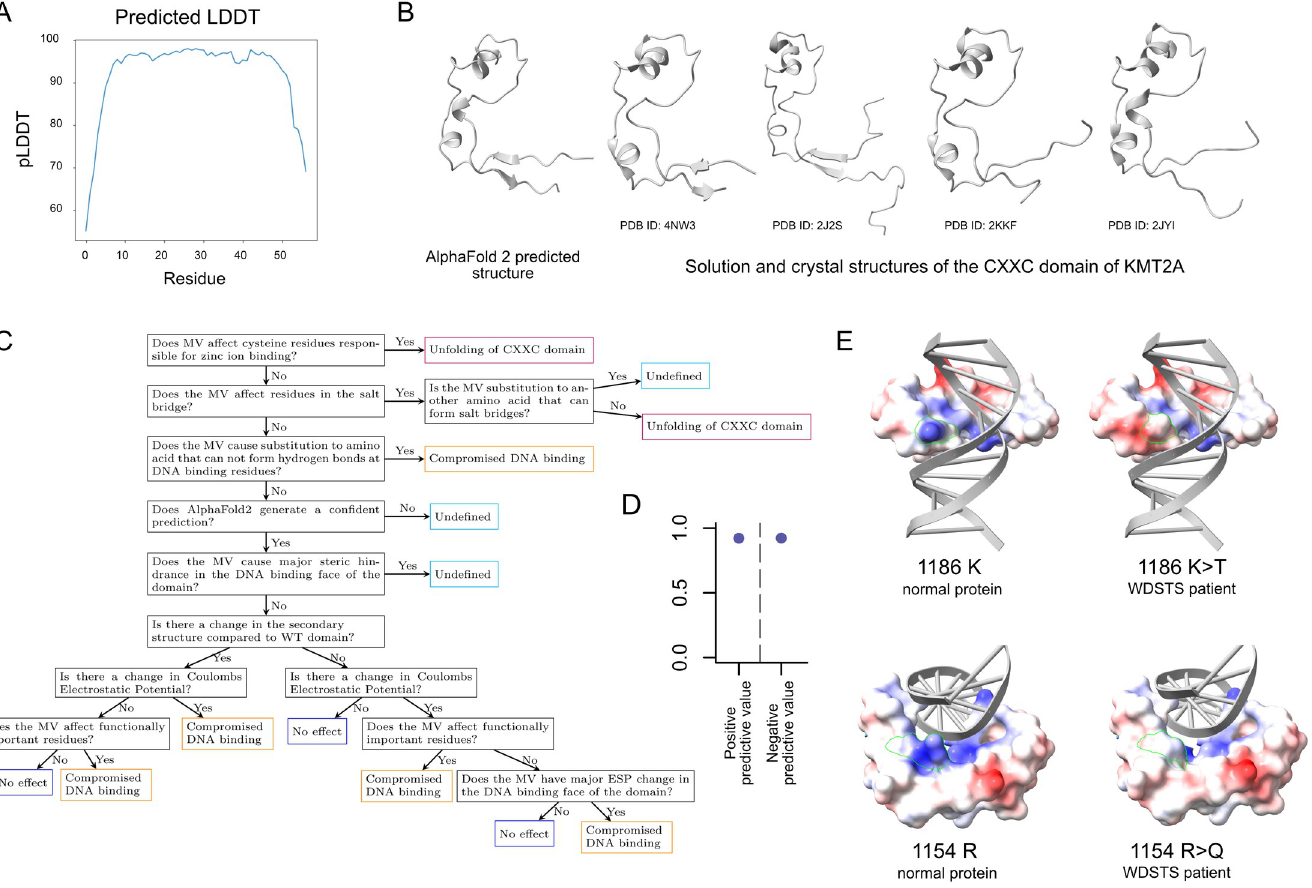
Fig 3. An AlphaFold2-based variant effect classification scheme for the CXXC domain of KMT2A. (A) Predicted LDDT values for the CXXC domain of KMT2A. (B) The AlphaFold2-predicted and experimentally determined structures of the CXXC domain of KMT2A. (C) The variant effect classification scheme. See Methods for details on the derivation of the scheme. (D) The positive and negative predictive value that the classifier shown in (C) attained on a hold-out test set consisting of 41 missense variants (see main text and Methods for details). (E) The position of two different missense variants in the 3D structure of the CXXC domain, in conjunction with a 3D representation of the engaged DNA backbone. For comparison, the same representation is shown for the normal protein as well (PBD � ID: 4NW3). The surface of the domain is color-coded based on the electrostatic potential, with red indicating a negative charge and blue a positive charge. Both variants lead to a decreased electrostatic potential in a residue important for DNA